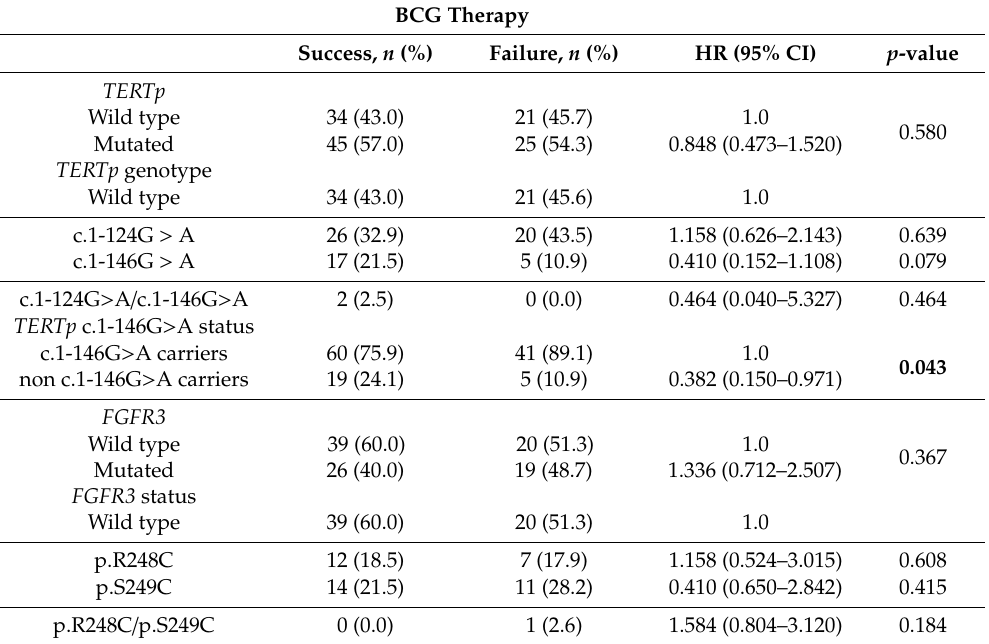
Table 4. Univariate analysis of the relation between TERTp and FGFR3 mutations and recurrence after BCG